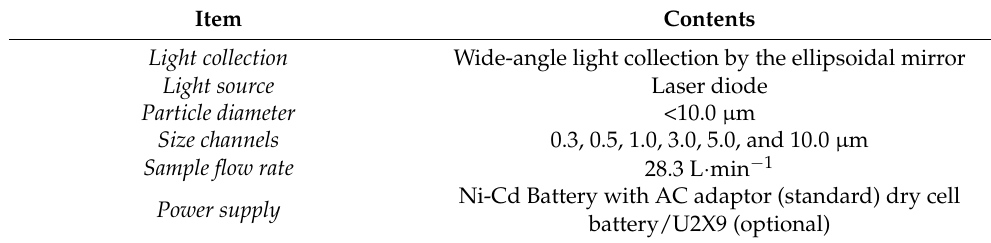
Table 1. Specification of the laser particle counter